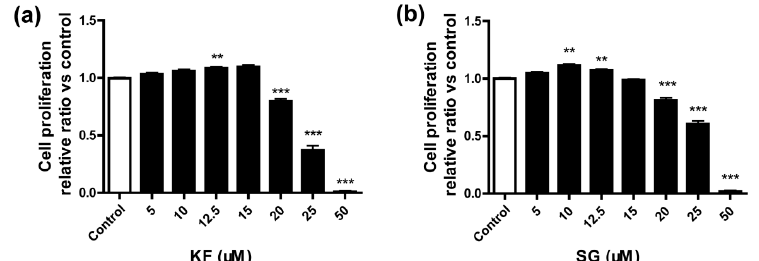
Figure 3. Evaluation of the cytotoxic effects of ( a ) Kushennol F (KF) and ( b ) Sophoraflavone (SG) in RAW264.7 pre-osteoclastic cells. Cell viabilities were measured by MTS assay. Data are means ± SEM ( n = 5) and ** p < 0.01 and *** p < 0.001 versus vehicle group.